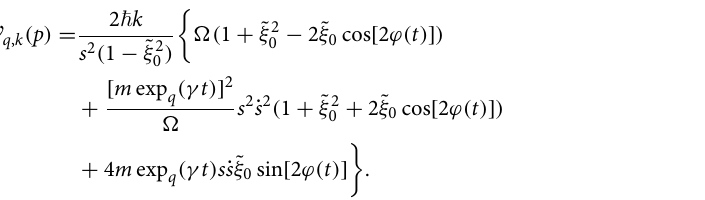
0.5 and = 1 and γ 1.00 . We used ω 0.1 = = =